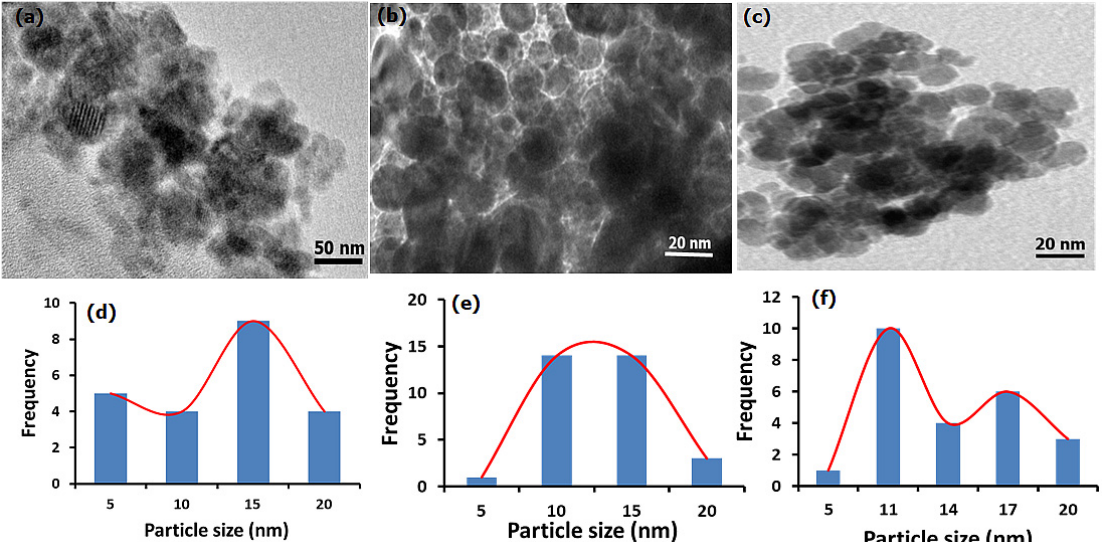
Figure 1. Comparison of HRTEM morphology ( a – c ) and the corresponding size distributions ( d – f ) for the samples of ESCaCO 3 NPs, RHSiO 2 NPs, and CS-SiO 2 /CaCO 3 NCs respectively.